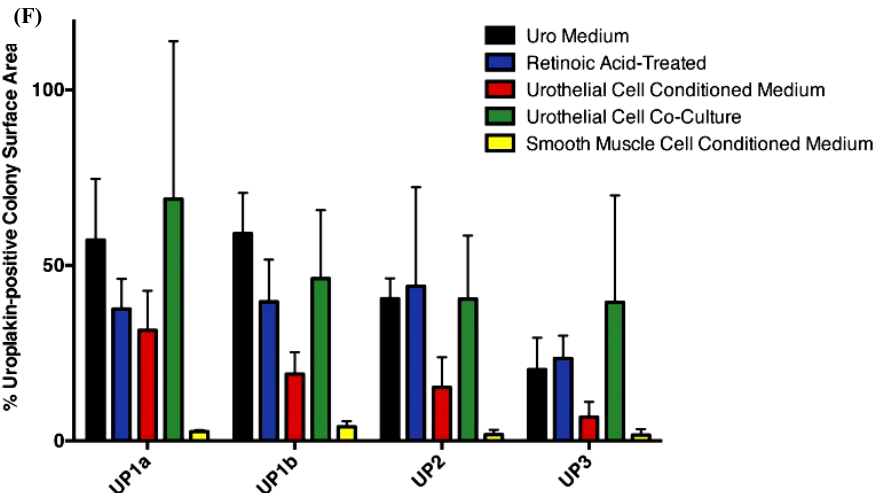
Figure 4. In vitro urothelium differentiation of hESCs. (A) Schematic diagram illustrating the protocol for urothelium differentiation of hESCs. (B) Intracellular cytokine flow cytometry analysis for the expression of UP subtypes (green color) on days 6, 12, 18, and 21 after DE were analyzed for the expression of all four subtypes of uroplakins (green) by intracellular cytokine flow cytometry. For nuclear counterstaining, DAPI (4 ′ ,6-diamidino-2-phenylindole; blue) was used. Magnification, 10×. (C) Images of cultured human urothelium and hESC-derived urothelium using bright-field microscopy on day 21 of the culture. Magnification, 10×. (D) Flow cytometry analysis of UP expression on day 21 of culturing. (E) Flow cytometry analysis for UP1a of H9-derived urothelial cultures at each passage (P 1–3). DE, definitive endoderm. (F) ImageJ-based quantification of the expression of each uroplakin subtype that obtained from the intracellular cytokine flow cytometry data (Figure 4B) from day 21 of culture using the five culture conditions that represented by bars of different colors. The vertical axis of Figures D and E represents the relative uroplakin expression amount to the colony surface area that expressed in percentage. hESCs, human embryonic stem cells. DE, definitive endoderm. hESCs, human embryonic stem cells. RA, retinoic acid. EGF, epidermal growth factor. PPAR γ , peroxisome proliferator-activated receptor γ . UP, uroplakin. FBS, fetal bovine serum. These figures are reproduced from articles by Osborn et al. 2014 [14] following permission from John Wiley and Sons. In flow cytometry data, the grey histogram denotes the negative control and the solid blue line indicates the positive uroplakin staining. Up arrow (red-colored) represents the treatment of hESCs with a gradual increase in the concentration of FBS for three days that followed by Activin A treatment for nine days. Up arrow (black-colored) indicates the time point (on day 18) of adding PPAR γ activator, troglitzone, and removal of EGF for induction of the terminal differentiation.